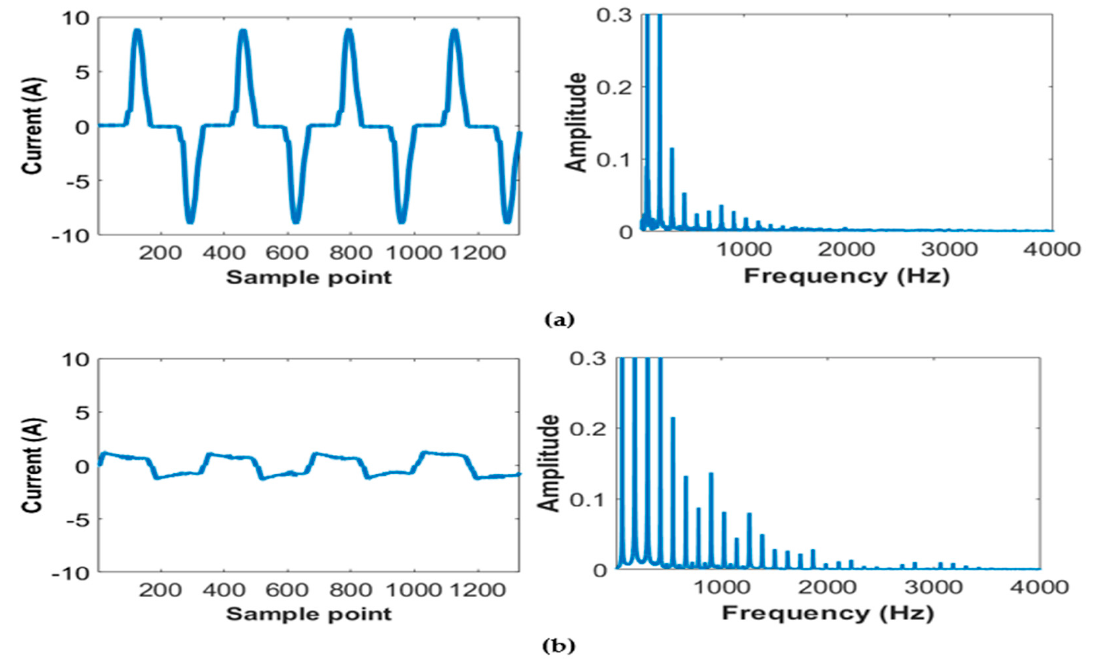
Figure 4. Measurement results for spiral energy saving bulbs ( a ) normal state, ( b ) arc fault state.